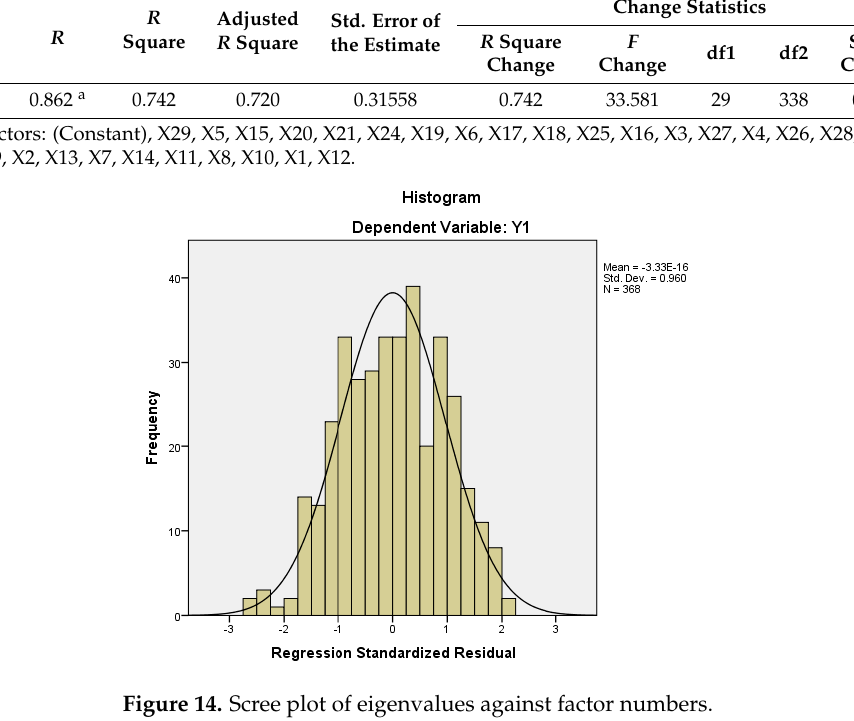
Figure 14. Scree plot of eigenvalues against factor numbers.